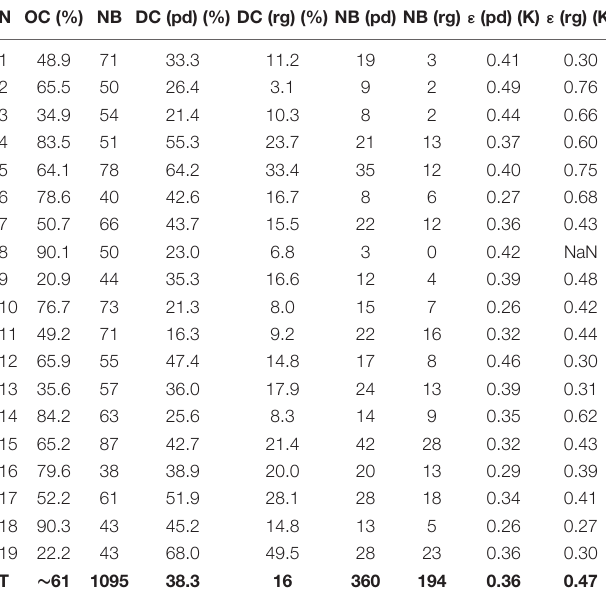
TABLE 4 | Statistical information of retrieved results for 18 granules from BB using two different methods of PDSST and RGSST5 for the month of December